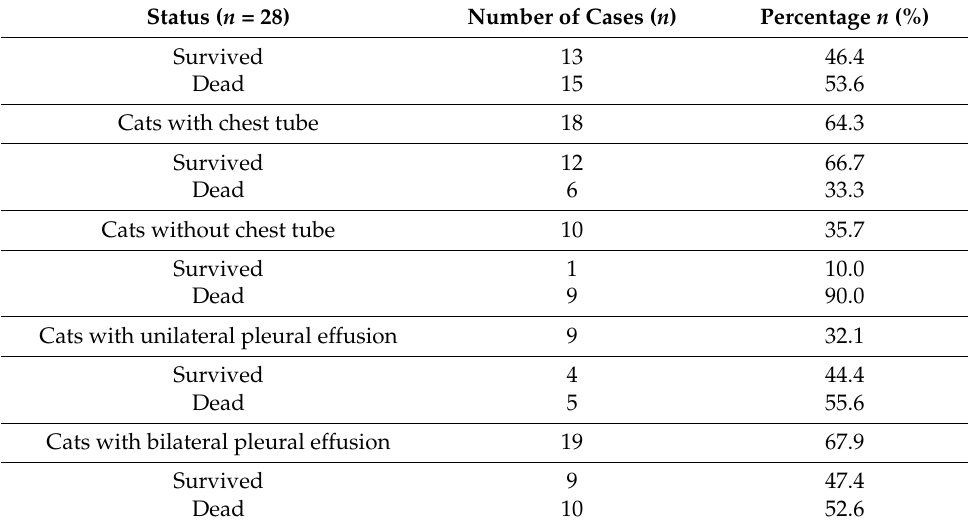
Table 11. Case outcome of the cats across different treatments or conditions.